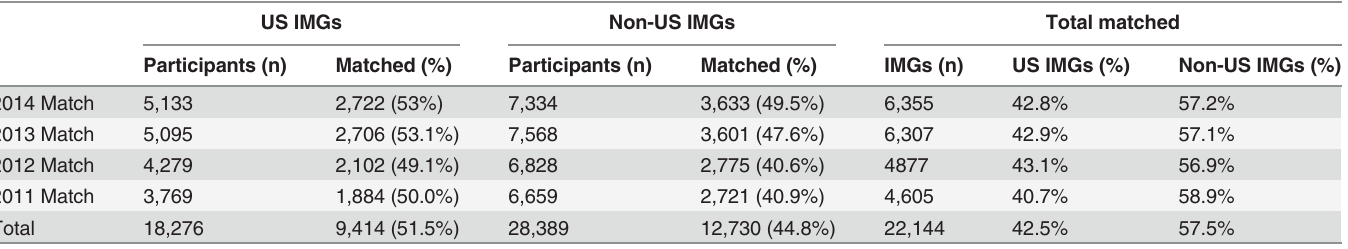
Table 1. Numbers and percentages of US and non-US citizens who graduated from international medical schools in the National Residency Match Program after the 2010 launch of the